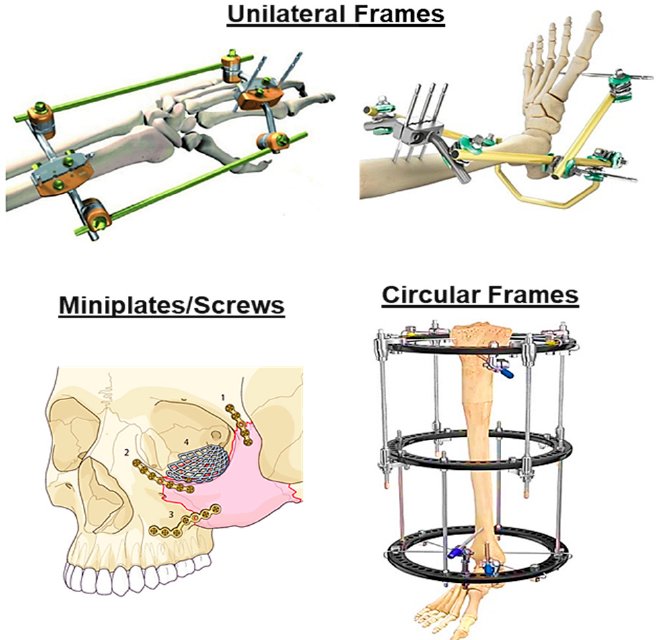
Figure 5. External fixation devices such as unilateral frames [41] placed on one side of the ankle or distal bone and miniplates or screws including pins for molar bones and circular frames [42] placed around the long bone, allowing functionality and bone stability during the bone healing process.